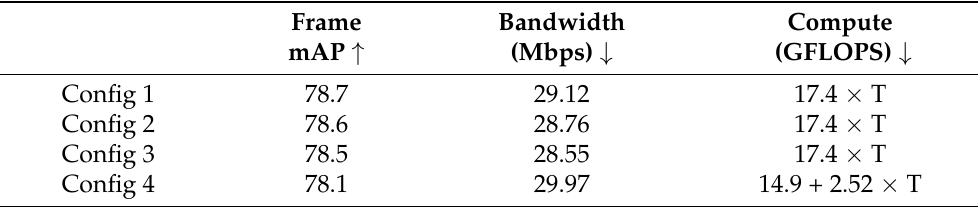
Table 3. Ablation Study on Feedback Configurations with Spatial and Temporal